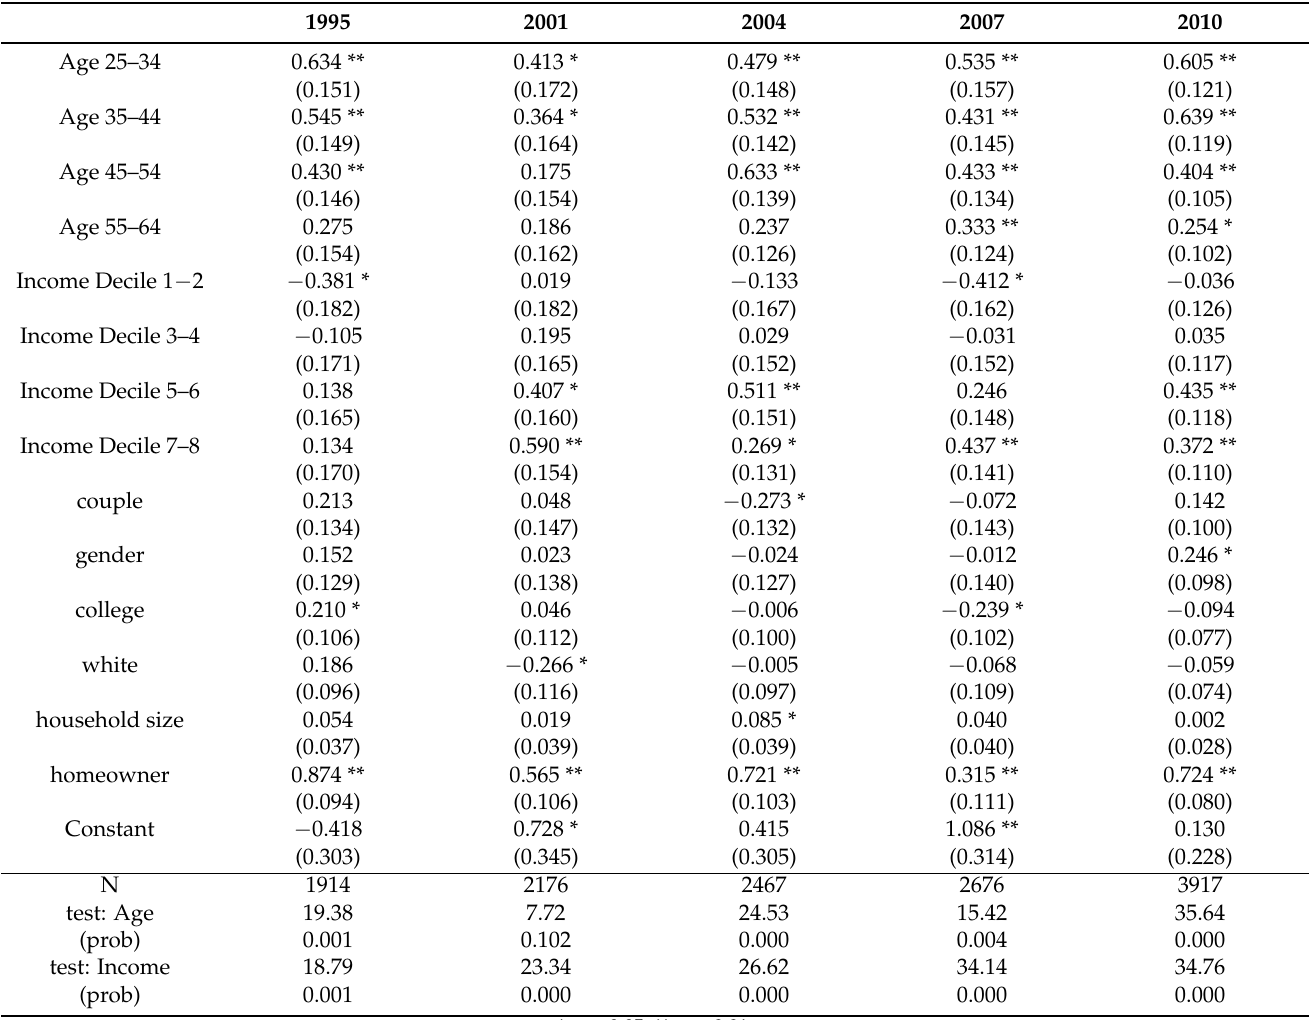
Table A2. Probability of Borrowing Among